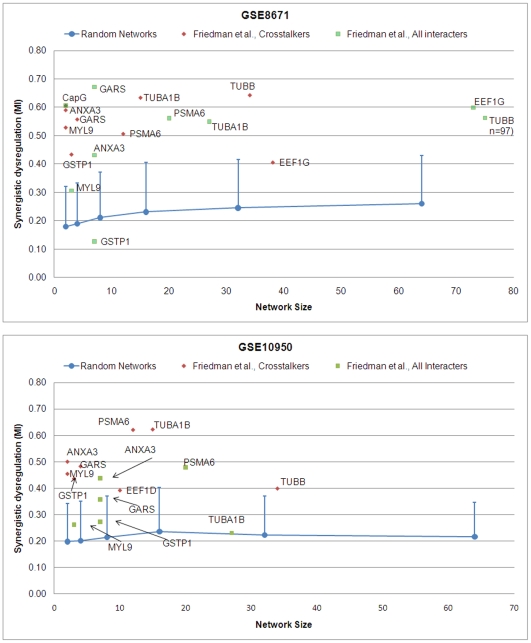
Synergistic dysregulation versus network size for candidate sub-networks associated with proteomic seeds obtained from Friedman et al.Please see Figure. 3 for annotation.